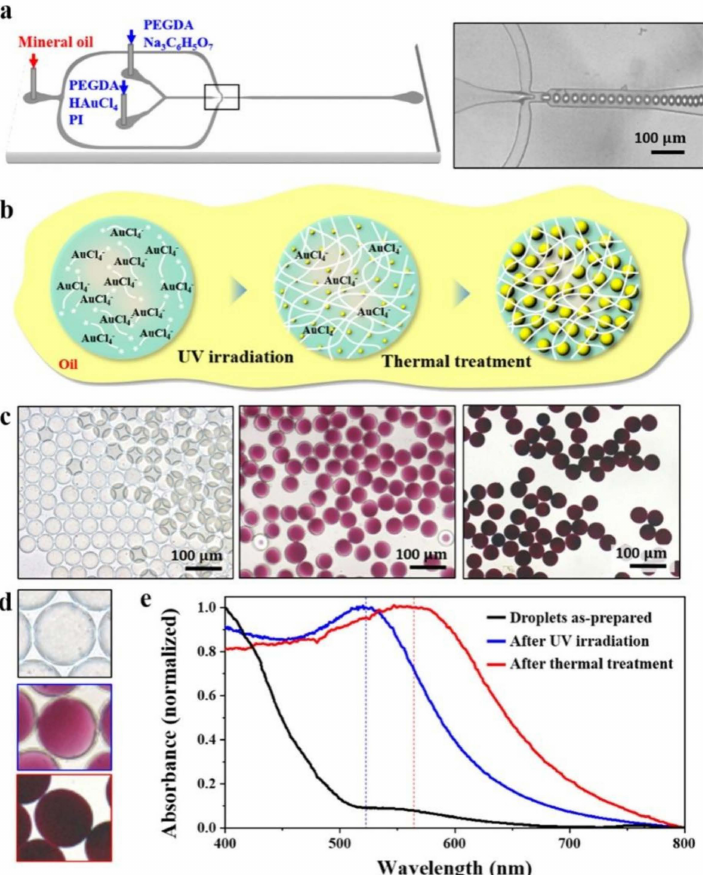
Figure 4. Production of plasmonic microgels. ( a , b ) Schematics of the microfluidic device and optical microscopy (OM) image showing the formation of monodisperse emulsion droplets at the cross-junction in the device. ( b ) Series of drawingss showing the formation of hydrogel and gold nanoparticles in a water-in-oil droplet by UV irradiation and the growth of the gold nanoparticles by thermal treatment. ( c ) OM images of emulsion droplets as-prepared (left panel), microgels transferred in water after UV irradiation (middle panel), and microgels transferred in water after UV irradiation and thermal treatment (right panel). ( d ) Magnified OM images of droplets and microgels in panel ( c ). ( e ) Absorbance spectra of the droplets as-prepared (black curve), microgels formed by UV irradiation (blue curve), and microgels formed by UV irradiation and thermal treatment (red curve) in the oil phase [31]. Copyright 2020, American Chemical